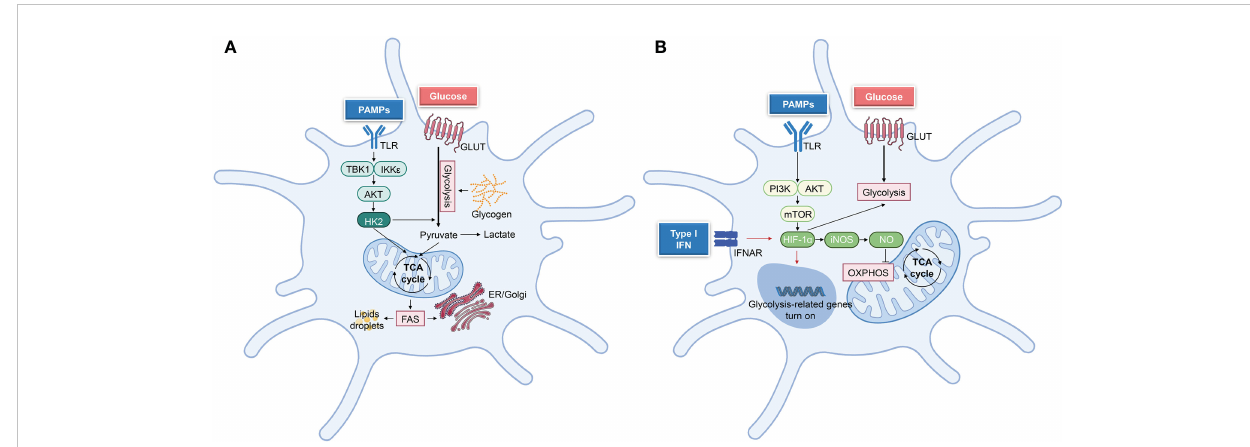
FIGURE 4 Principal metabolic reprogramming pathways after DCs activation. (A) TBK1-IKK e -Akt-HK2 signaling regulates the short-term (minutes to hours following TLR ligation) metabolic regulation in DCs, which undergo rapid metabolic reprogramming. This signaling pathway stimulates glycolysis, which in turn supports other metabolic processes, such as fatty acid synthesis (FAS) and lipid synthesis, hence facilitating DC activation. (B) In the later stage of DCs activation, iNOS-dependent glycolysis was performed. TLR ligation triggers PI3K/AKT, and mTOR-HIF1 a pathways to promote glycolysis, whereas iNOS-NO suppresses OXPHOS. While activated cDCs do not undergo iNOS-dependent glycolysis in vivo , autocrine type-I IFN signaling triggers HIF-1 a -mediated glycolytic reprogramming